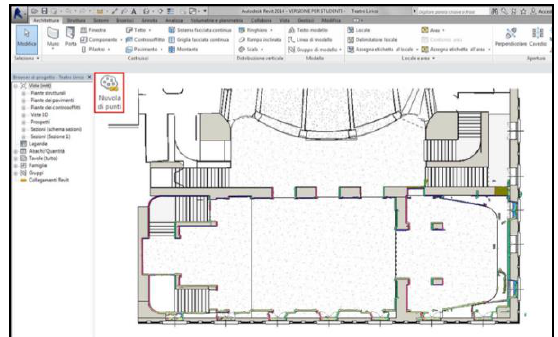
Figure 8. Plan created from the point cloud in BIM software Source: Municipality of